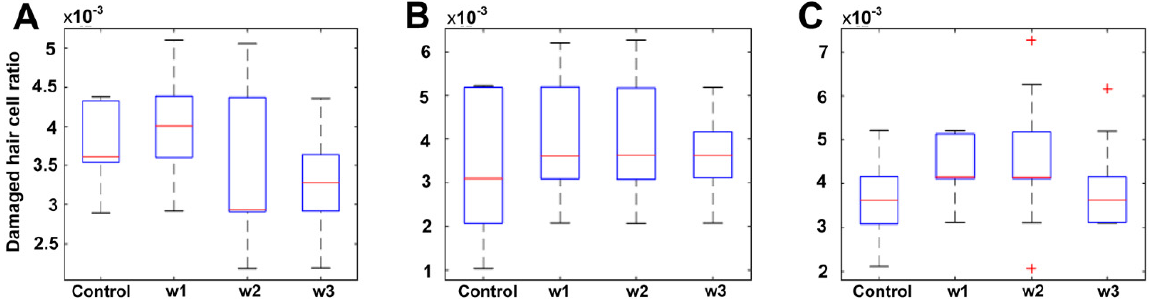
Figure 9. Overview of the damaged hair cell ratio from data collected at the LAB experiments. ( A ) lagena, ( B ) saccule and ( C ) utricle. The red line is the median with the boxes defined by the 25 and 75 percentiles. The whiskers are defined by 1.5 times the interquartile distance and outliers (+) beyond that range. No significant differences were found between controls and exposed salmons ( p -values: ( A ) 0.21, ( B ) 0.92, ( C ) 0.54).